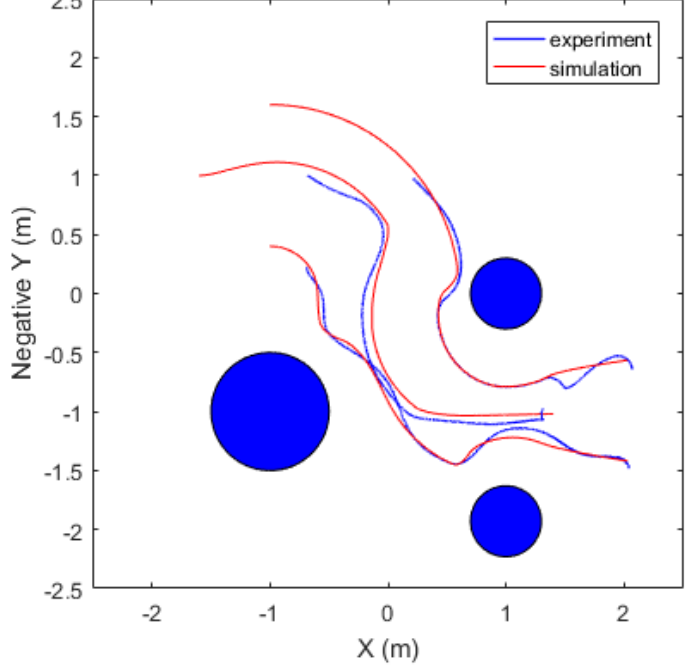
Figure 19. The trajectories of simulation and experimental results under